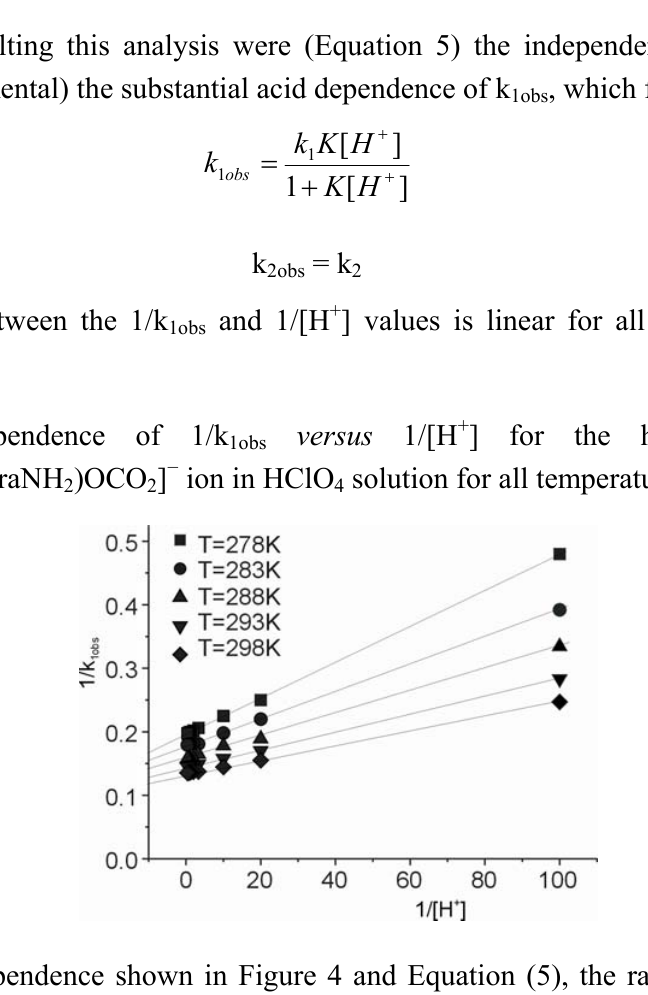
4. Dependence of 1/k